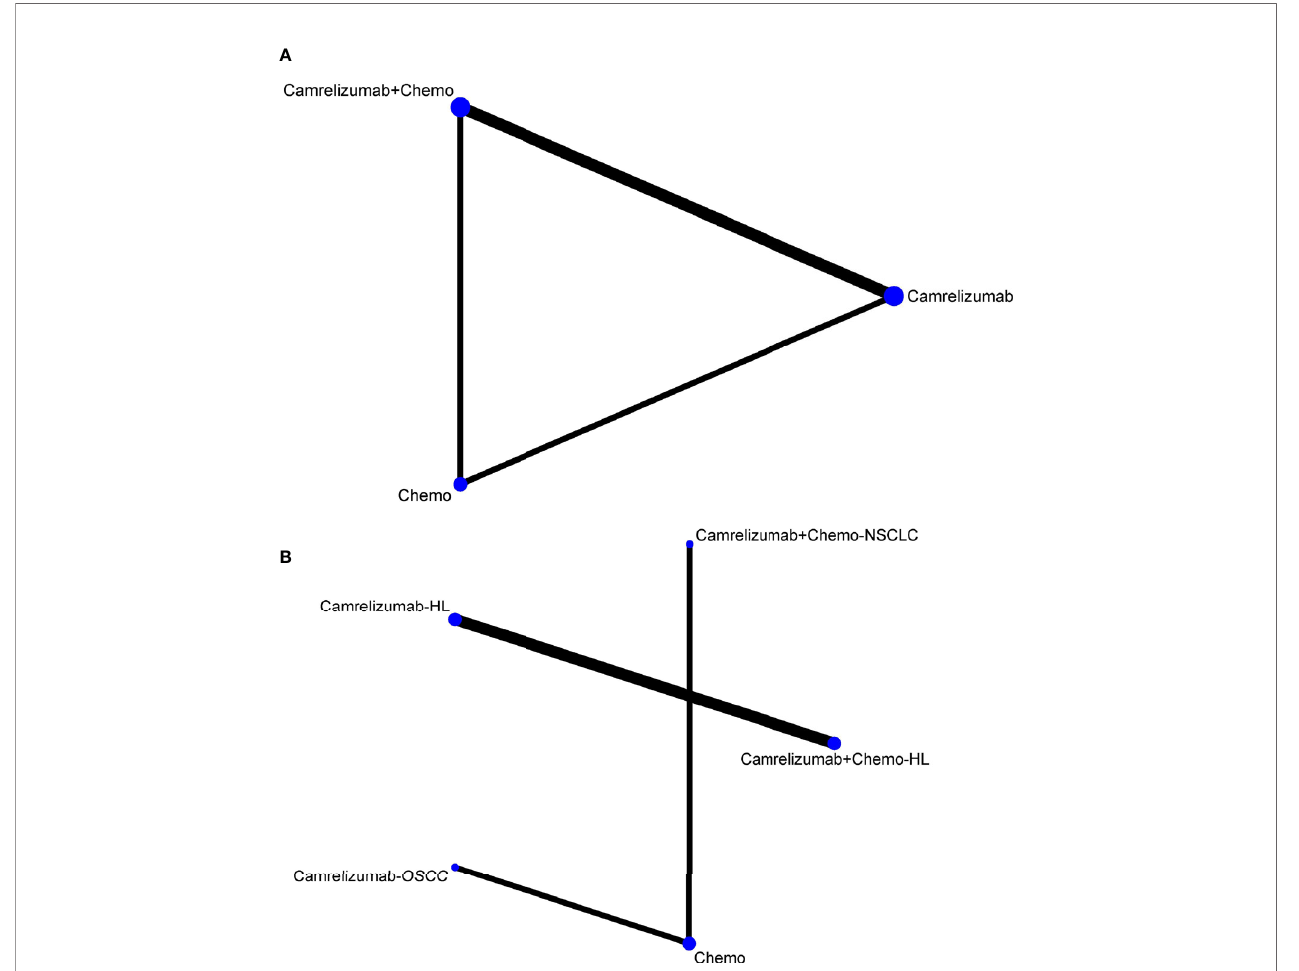
FIGURE 2 | Network of eligible comparisons (A) without malignant subtypes, (B) with malignant subtypes. The width of the lines is proportional to the number of clinical trials comparing every pair of direct comparison, and the size of each node is proportional to the number of patients with malignant assigned. Chemo, chemotherapy; HL, Hodgkin lymphoma; OSCC, esophageal squamous cell carcinoma; NSCLC, non-squamous non-small-cell lung